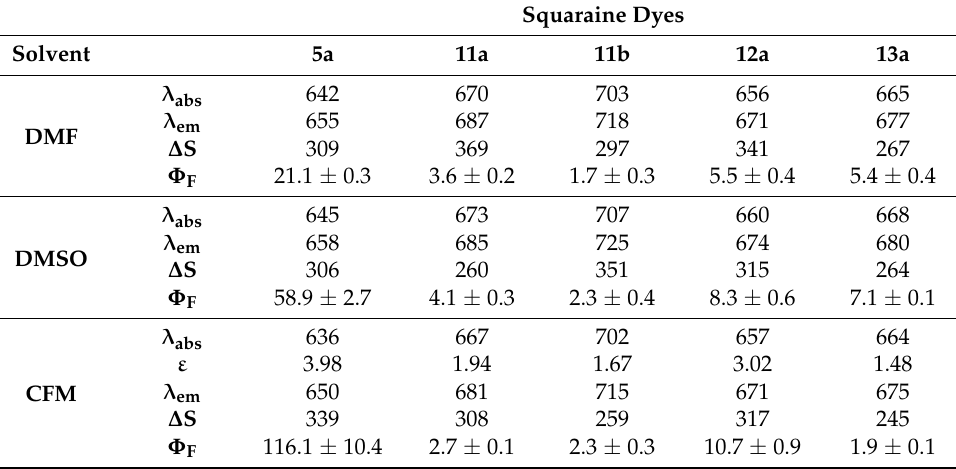
Table 2. Maximum absorption and emission wavelengths ( λ abs and λ em , respectively; in nm), Stokes shift ( ∆ S; cm − 1 ), and relative fluorescence quantum yields [ Φ F ; in percentage (%)] of squaraine dyes 5a , 11a , b , 12a , and 13a in dimethylformamide (DMF), dimethyl sulfoxide (DMSO), and chloroform